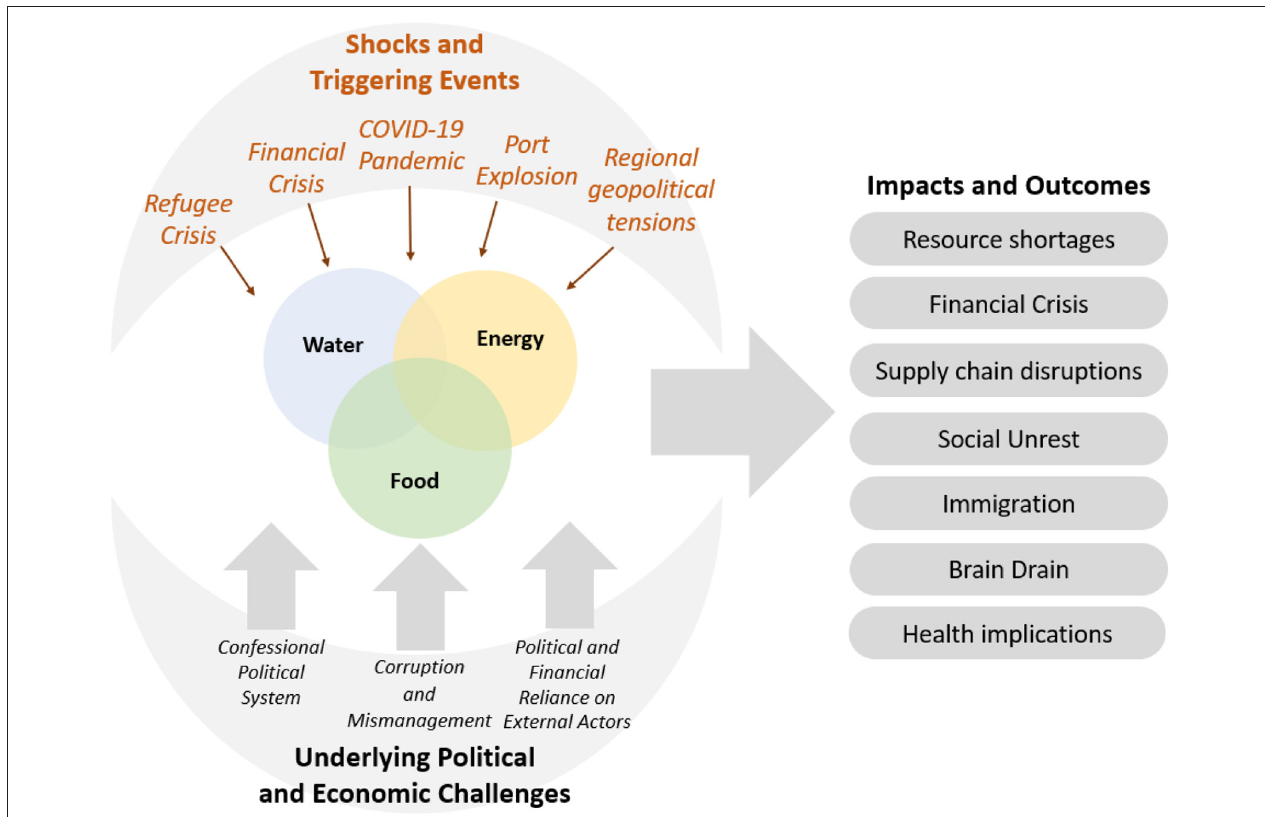
FIGURE 2 | The long-term underlying conditions, compound shocks and triggering events, and impacts and outcomes.